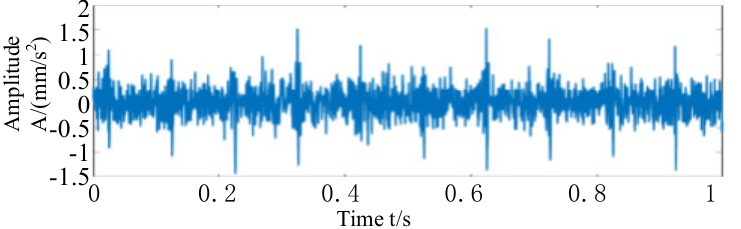
Figure 10. Time-domain waveform diagram of a synthesized signal with the harmonic components removed when sparsity K = 10.